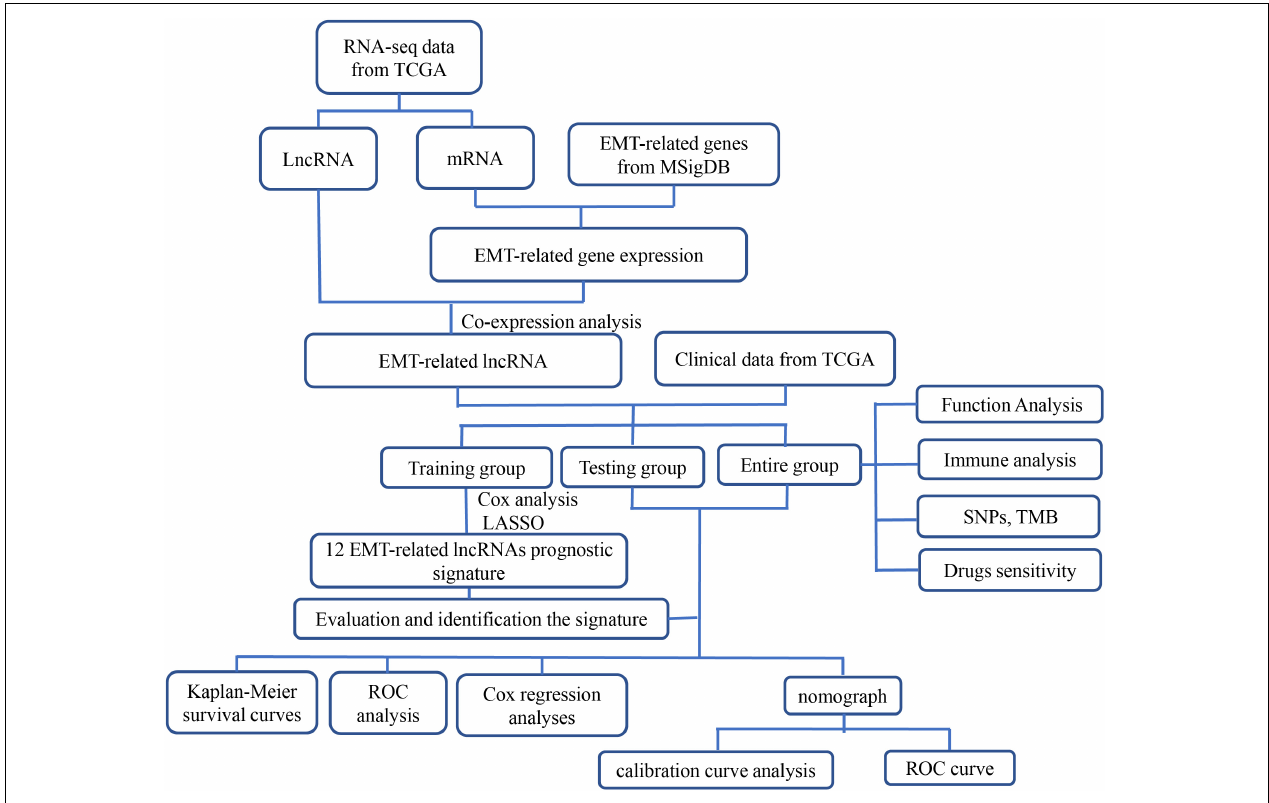
FIGURE 1 | Flowchart of this study. ETM, epithelial-mesenchymal transition; LncRNA, long non-coding RNA; LASSO, the least absolute shrinkage and selection operator; GSEA, gene set enrichment analysis; GO, Gene Ontology; TCGA, The Cancer Genome Atlas; ROC, receiver operating characteristic; SNPs, single nucleotide polymorphisms; TMB, tumor mutation